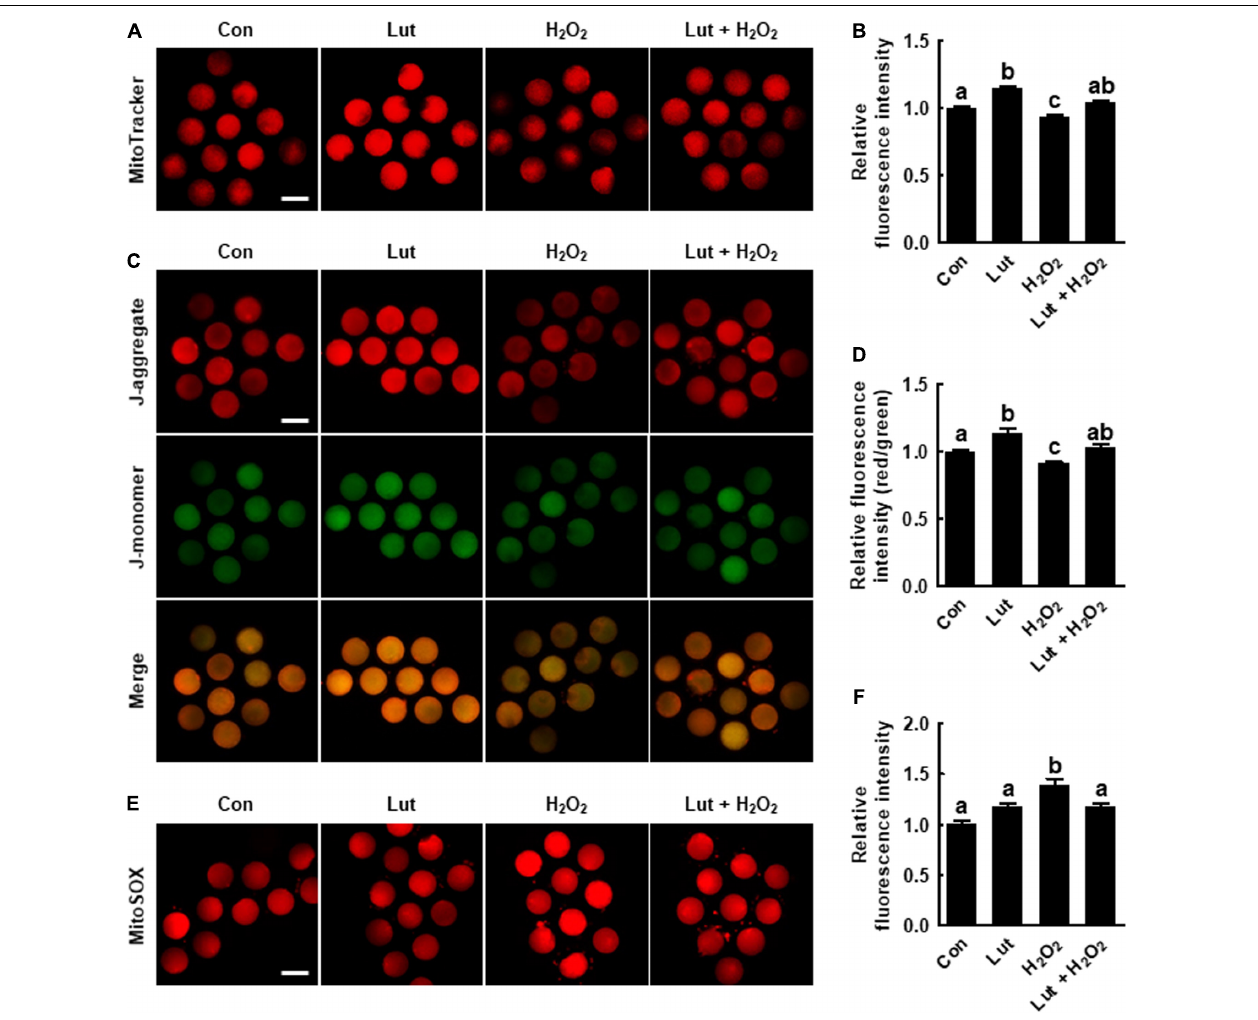
FIGURE 3 | Effects of Lut on H 2 O 2 -induced mitochondrial dysfunction and superoxide production. (A) Representative images of porcine oocytes stained with MitoTracker and (B) relative fluorescence intensities in the indicated groups (Con, n = 35; Lut, n = 35; H 2 O 2 , n = 35; Lut + H 2 O 2 , n = 35). Scale bar = 100 µ m. (C) Representative images of porcine oocytes stained with JC-1 and (D) the ratios of red to green fluorescence intensity in the indicated groups (Con, n = 35; Lut, n = 35; H 2 O 2 , n = 35; Lut + H 2 O 2 , n = 35). Scale bar = 100 µ m. (E) Representative images of porcine oocytes stained with MitoSOX and (F) relative fluorescence intensities in the indicated groups. Scale bar = 100 µ m. (Con, n = 34; Lut, n = 34; H 2 O 2 , n = 34; Lut + H 2 O 2 , n = 34). The data are from at least three independent experiments, and the different superscript letters represent the significant difference ( p <